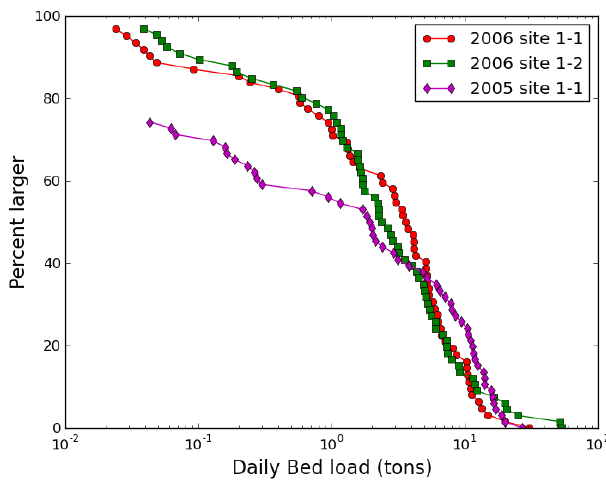
Fig. 9. Distribution of bed load fluxes: Proportion of daily bedload exceeding a given value in tons per